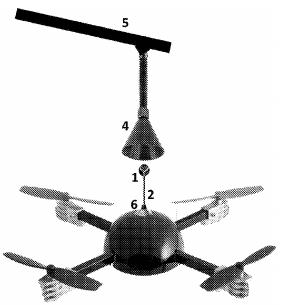
Figure 23. Landing platform for a vertical take-off and landing UAV with overhead cone funnel positioning [68]. 1, anchor; 2, anchor stand; 4, gripper; 5, base with open landing system; 6, housing for placing the electronic part of the control system; 7, UAV.